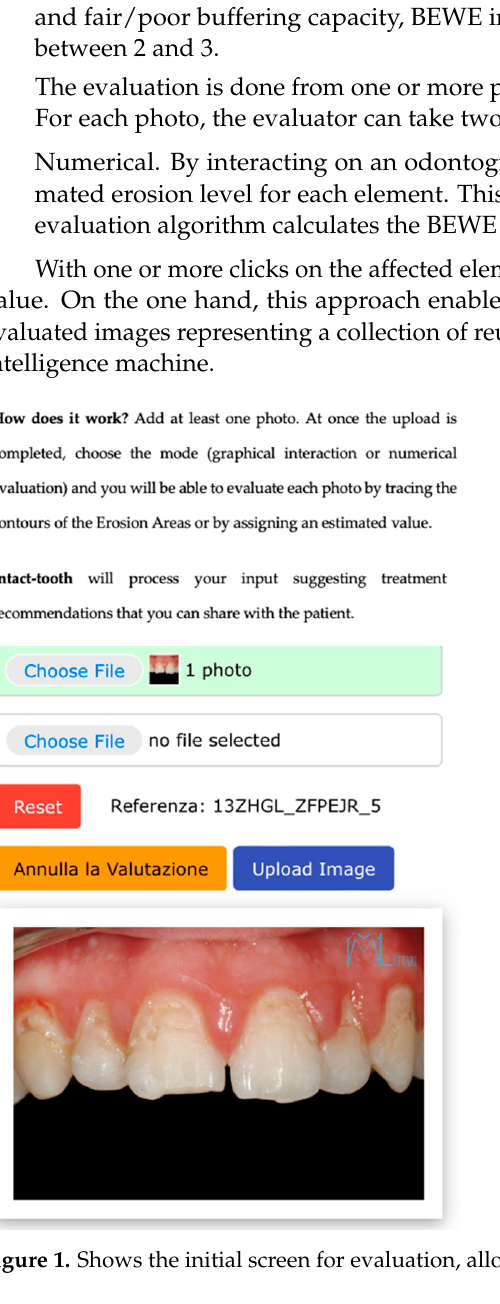
Figure 1. Shows the initial screen for evaluation, allowing the patient’s photo to be uploaded.